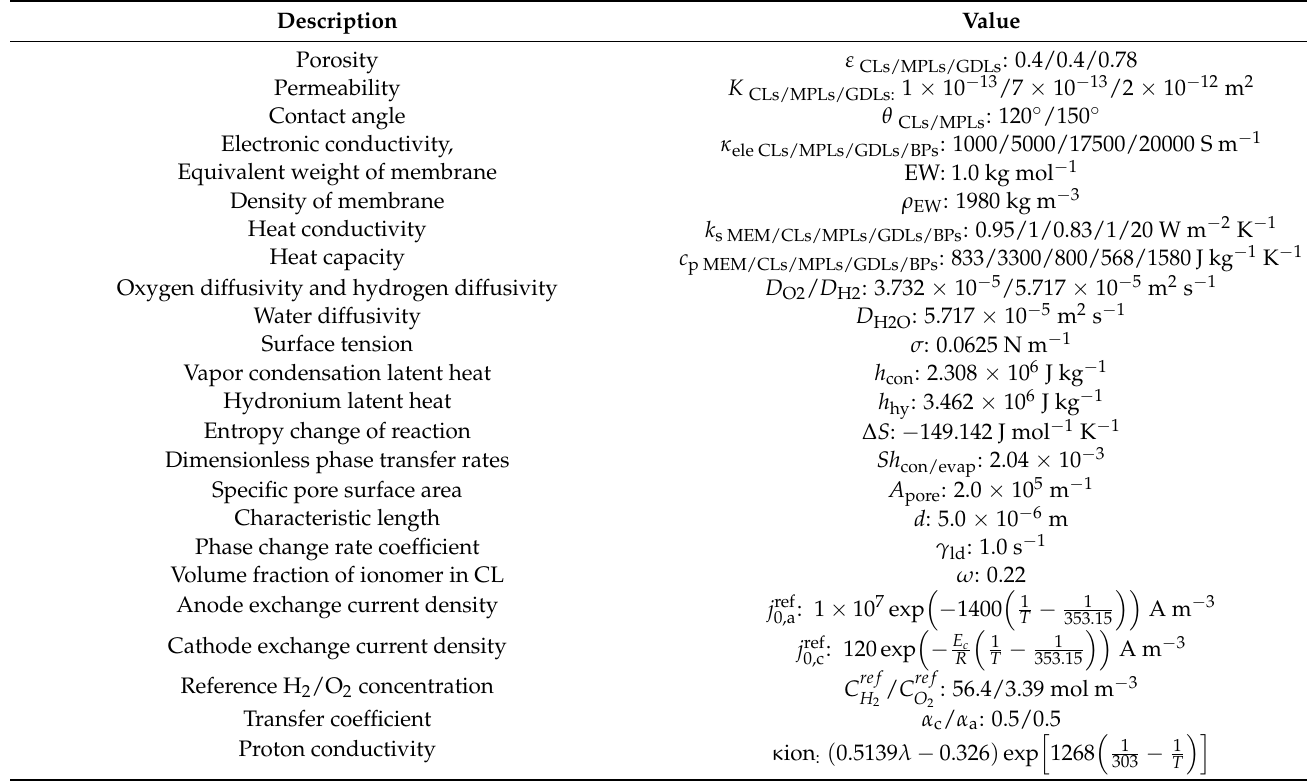
Table 4. Transport parameters and physical